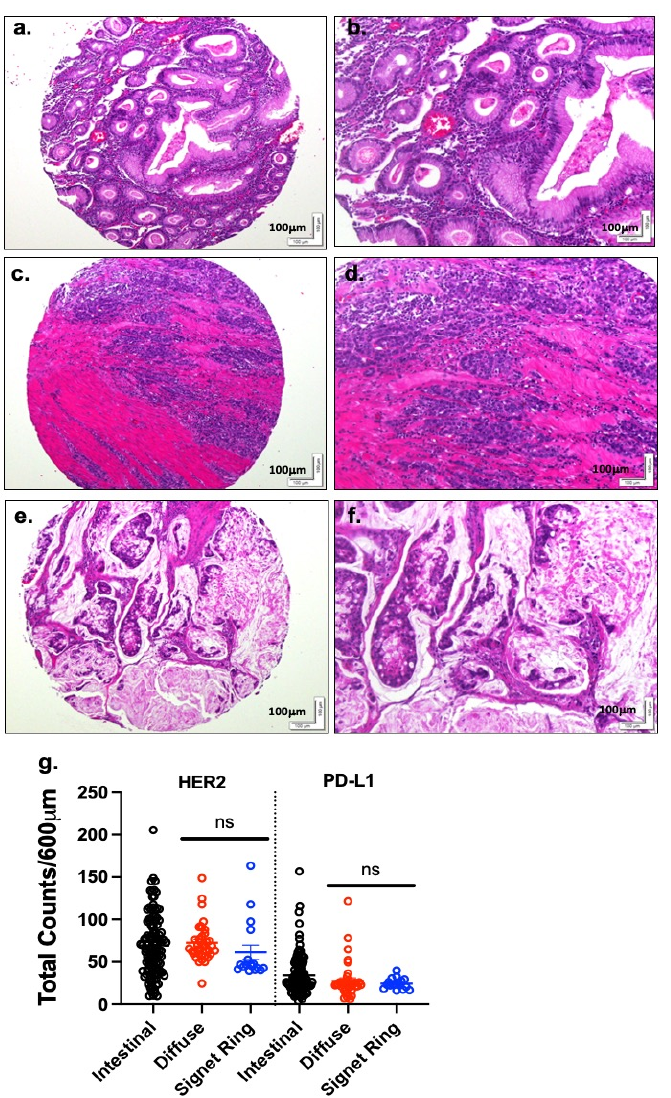
Figure 2. PD-L1 and HER2 expression in intestinal, diffuse and signet ring gastric cancer subtypes. H&E stain of ( a , b ) intestinal, ( c , d ) diffuse, and ( e , f ) signet ring gastric cancer subtypes. A higher magnification is demonstrated in panels ( b ), ( d ), and ( f ). ( g ) Quantification of HER2 and PD-L1 in the TMA using NanoString DSP. ns = not significant. Scale bar = 100 μ m